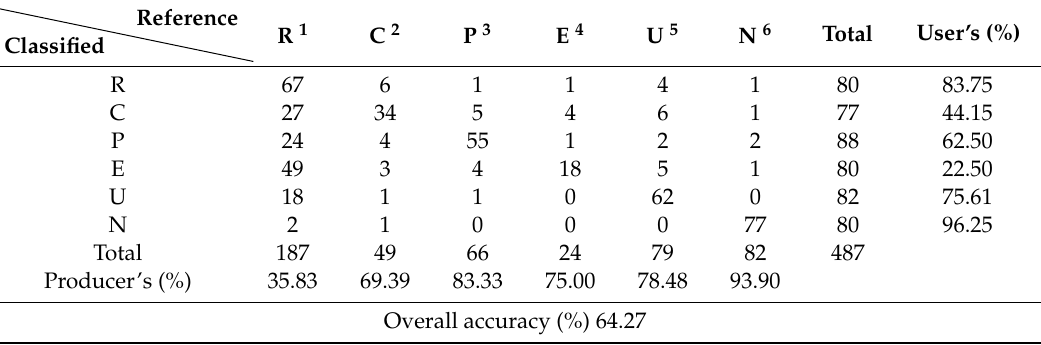
Table 4. Confusion matrix of block level land use mapping.